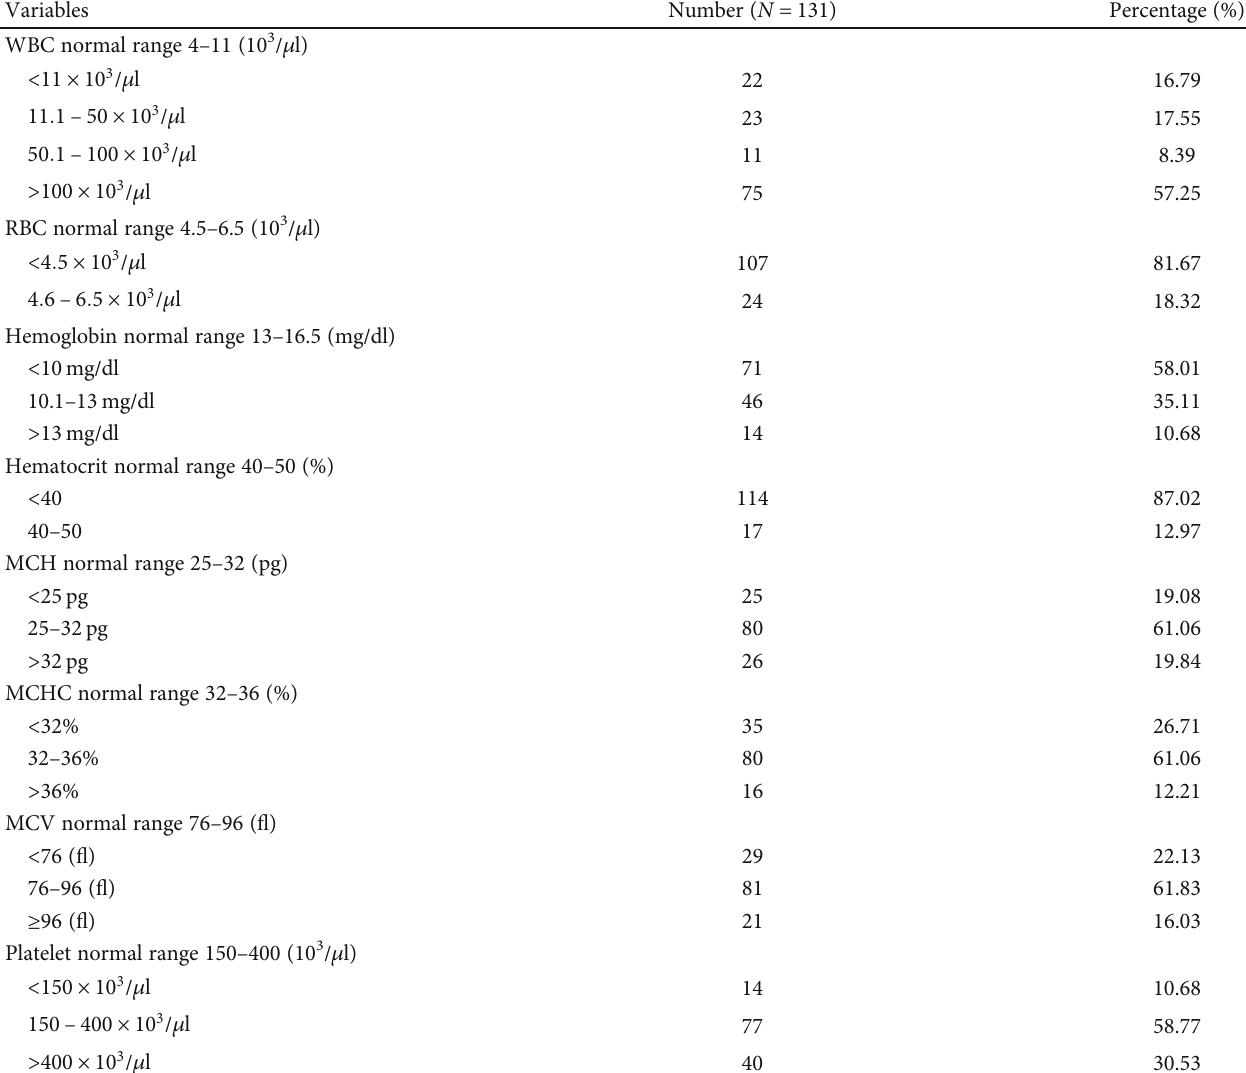
Table 2: Distribution of WBC, RBC, hemoglobin, HCT, MCH, MCHC, MCV, and